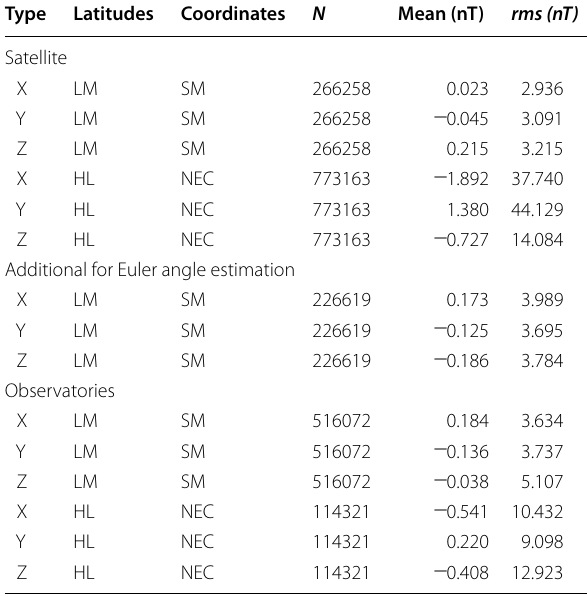
Table 2 Statistics of the satellite and observatory data used to obtain the Mag.num